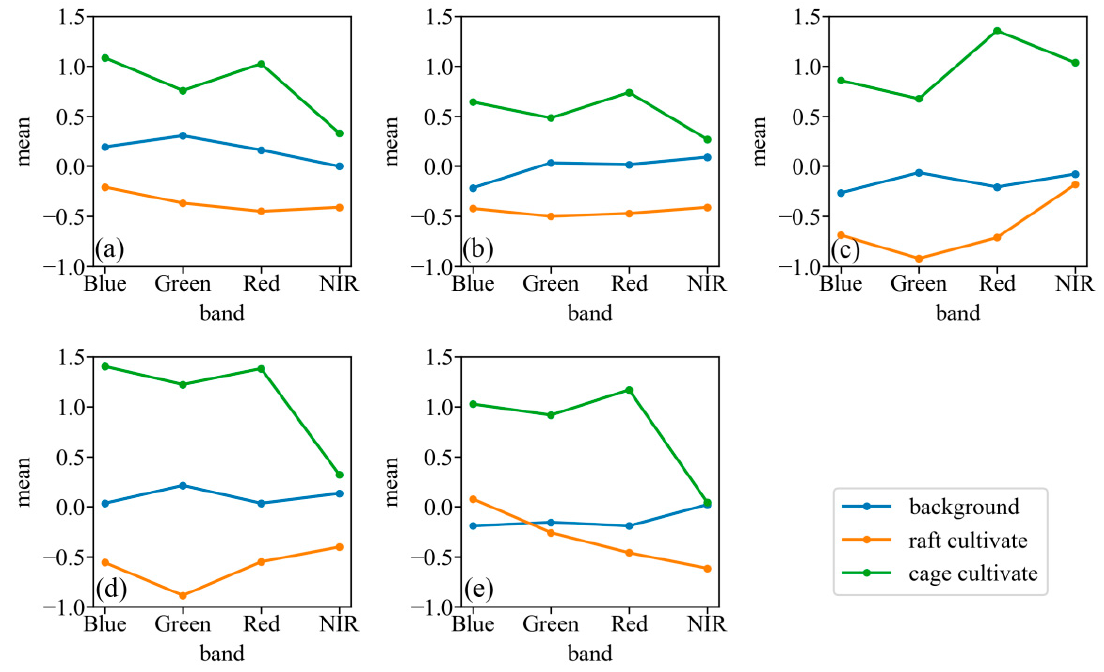
Figure 18. Spectral value of training data and test data after normalization. ( a ) Training data. ( b ) Test A. ( c ) Test B. ( d ) Test C. ( e ) Test D.